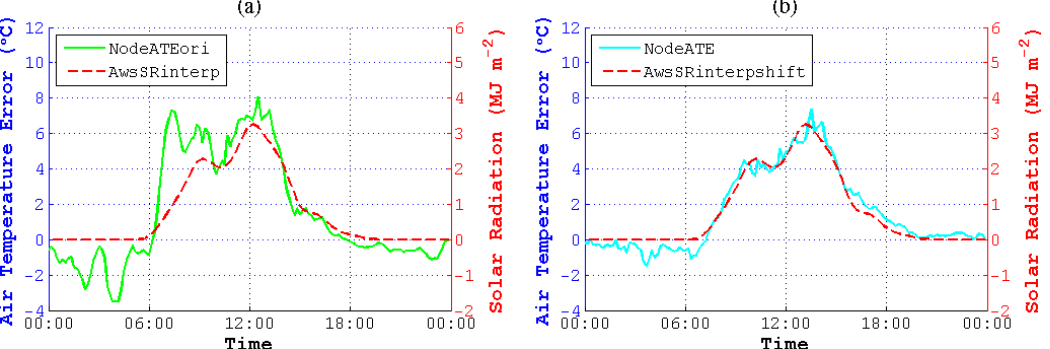
Figure 10. Contrast of AT error (ATE) and SR on 13 May 2014. ( a ) The enlarged ATE-SR pattern of Figure 8; ( b ) the enlarged ATE-SR pattern of Figure